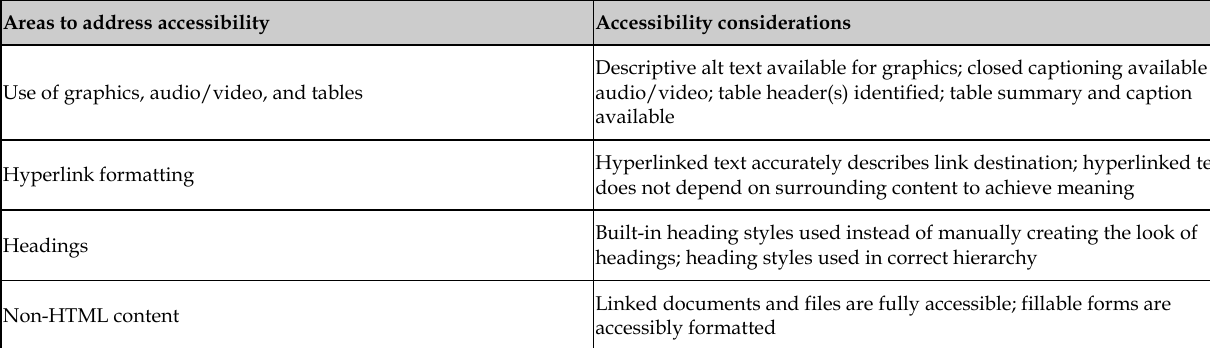
LibGuide editing platform (table is not